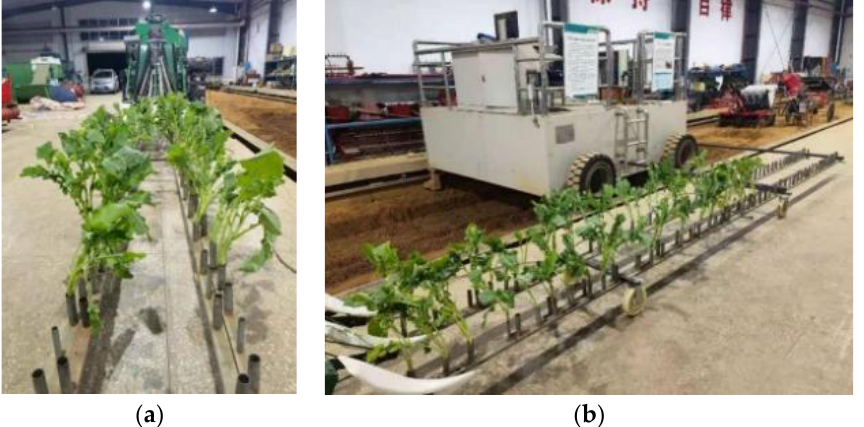
Figure 12. Bench test operation diagram: ( a ) front view; ( b ) side